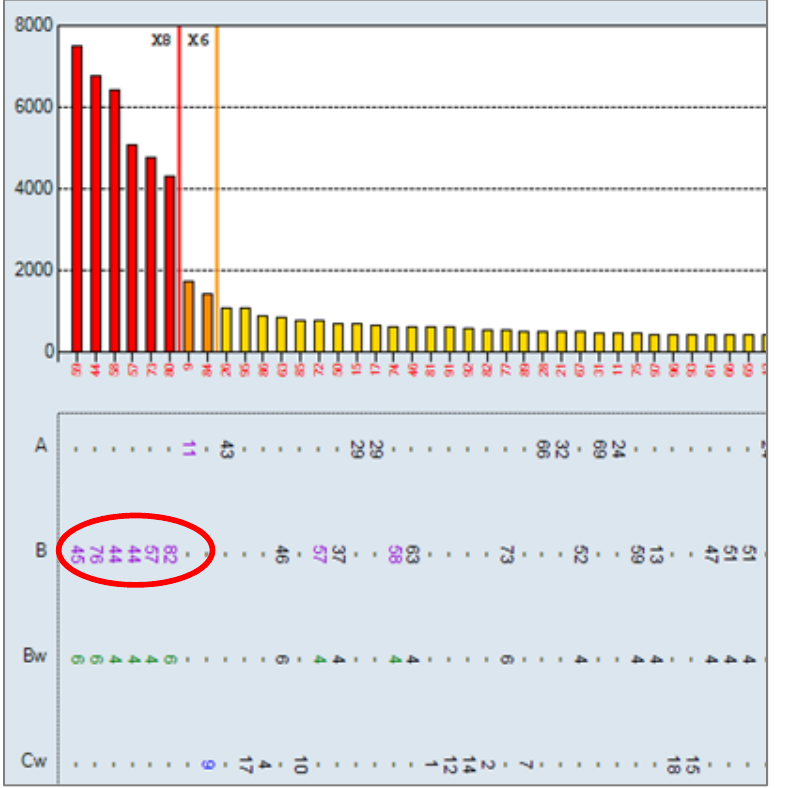
Figure 1. Single Antigen Class I results at 10 January 2018: positive for the specificities B45, B76, B44,